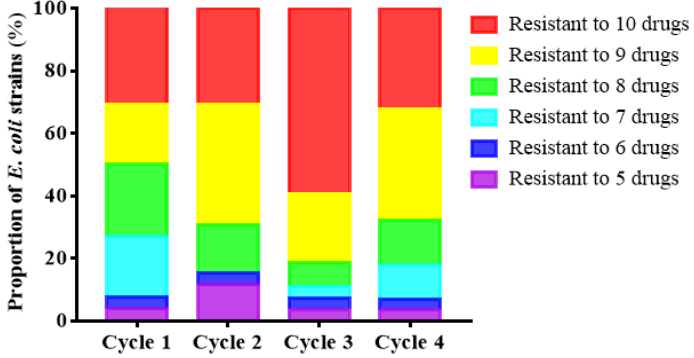
Figure 3. Resistance rates of 107 strains of E. coli to different antibiotics in different.